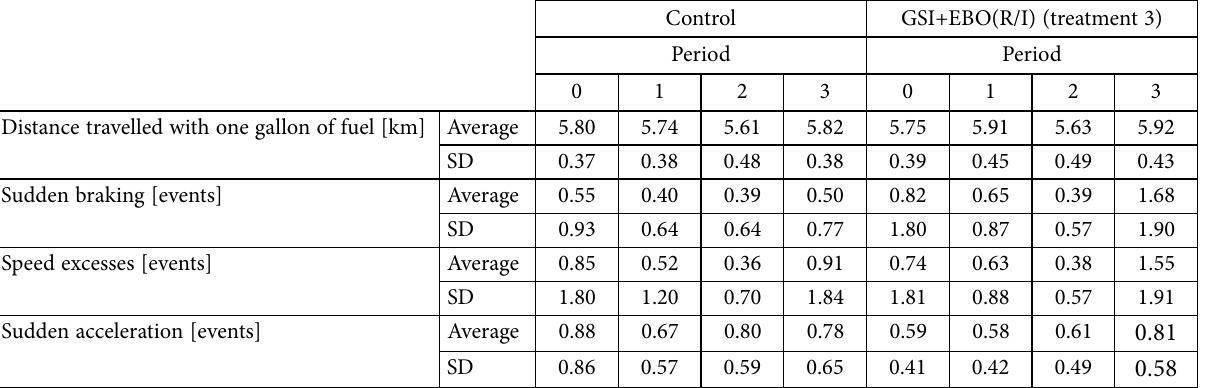
Table 6. DPAs for Case Study